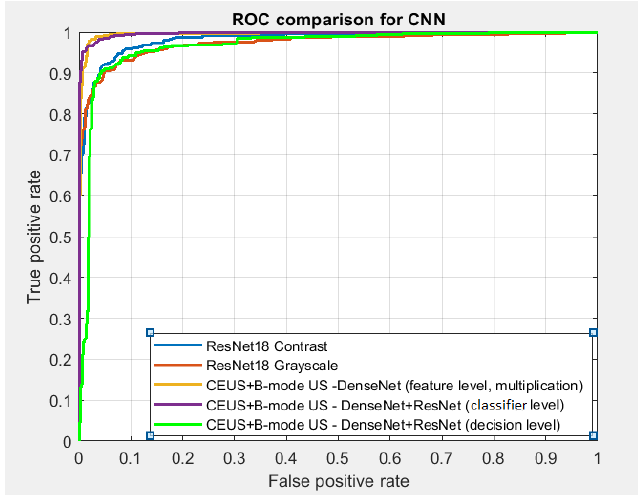
Figure 8. Comparison of the ROC curves for the best